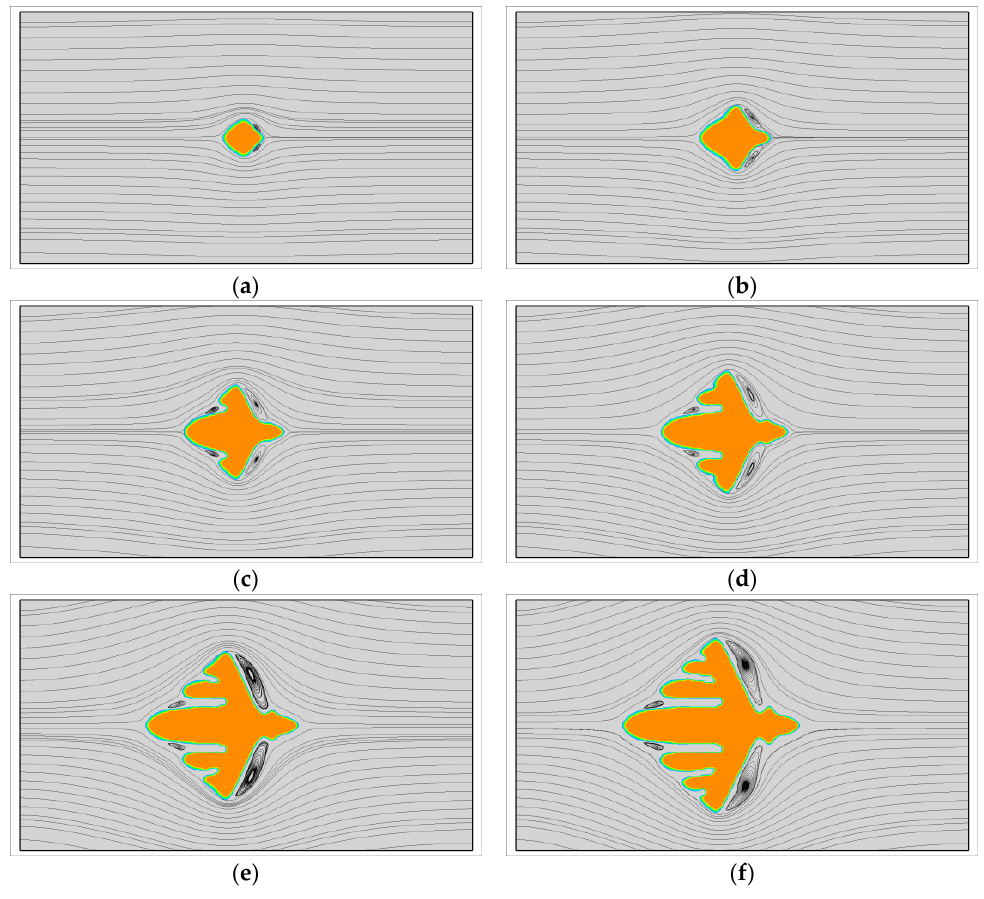
Figure 1. The growth of a dendrite under viscoelastic fluid flow with 0 1 . 0 u and 1 . 0 W e . In simulation, the dendritic morphology is triggered by the anisotropy with the number of mode j = 4. ( a ) t = 100; ( b ) t = 200; ( c ) t = 300; ( d ) t = 400; ( e ) t = 500; ( f ) t = 600.